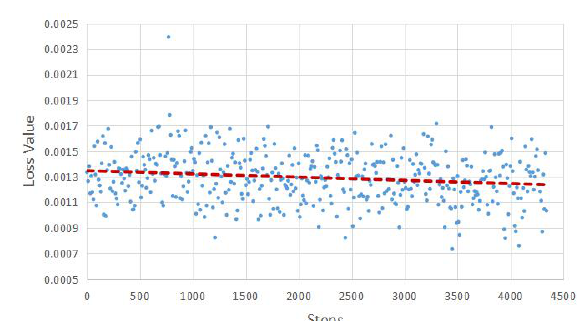
Figure 7. Best loss value of the proposed model.